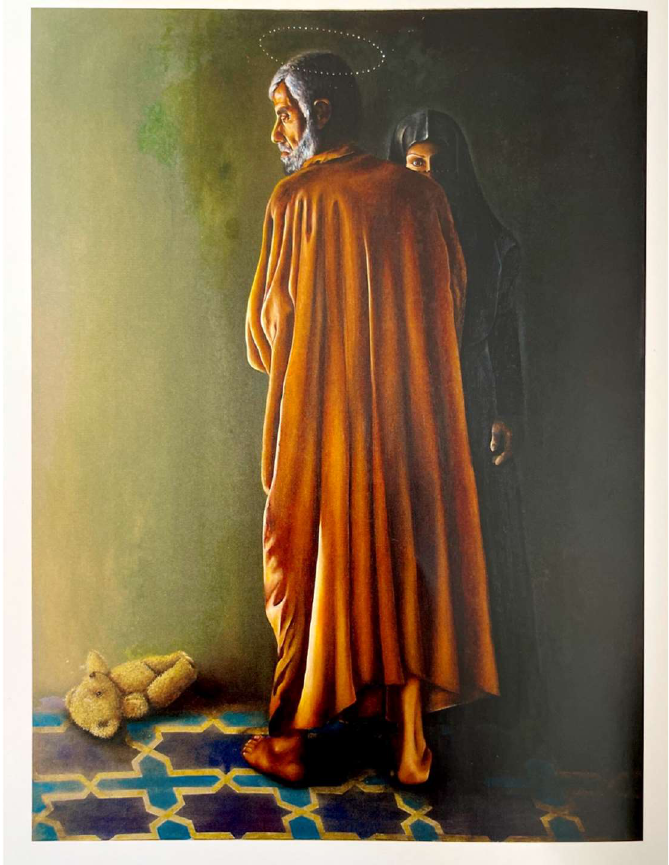
Figure 10. Fatma Abu Romi, “My Father and Me,” 2005, oil and zircons on canvas, 200 × 150 cm.